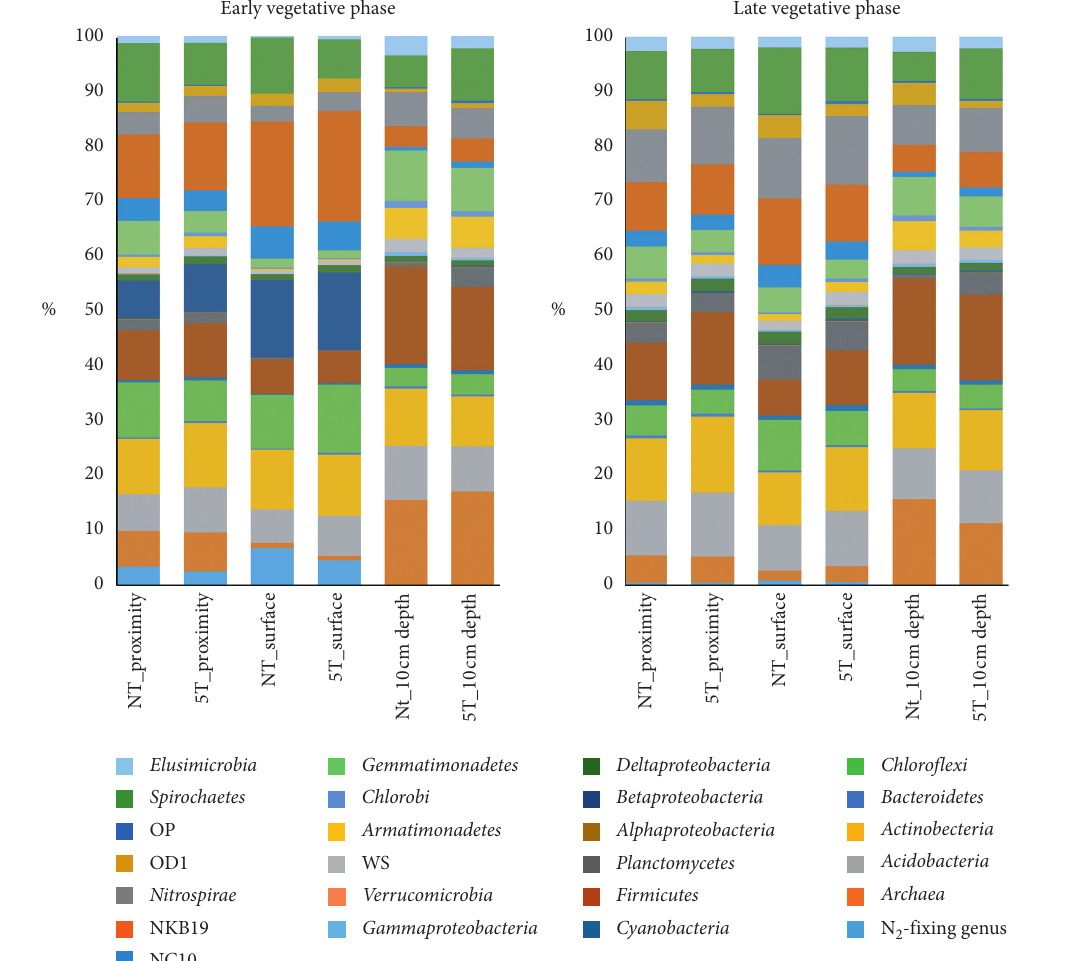
Figure 3: Relative abundances for the bacterial community under no tillage (NT) and 5 times tillage (5T) treatment in three different locations (rice proximity, surface, and 10cm depth) at early vegetative phase and late vegetative phase. Proteobacteria were shown in class level; “N 2 fixing genus” included Pseudomonas, Azoarcus, Rhizobium, Anabaena, Azospirillum, and Bradyrhizobium . Other bacteria were shown in phyla